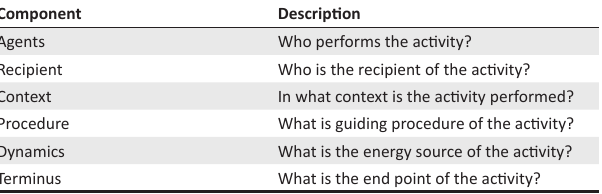
TABLE 2: Components of survey list according to Dickoff et al.